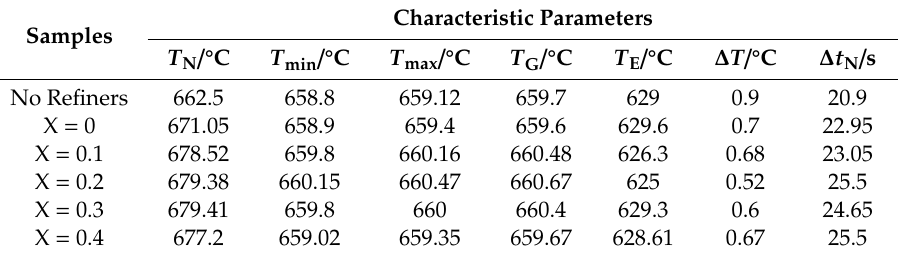
Table 5. Solidification characteristic parameters of industrial aluminum with di ff erent